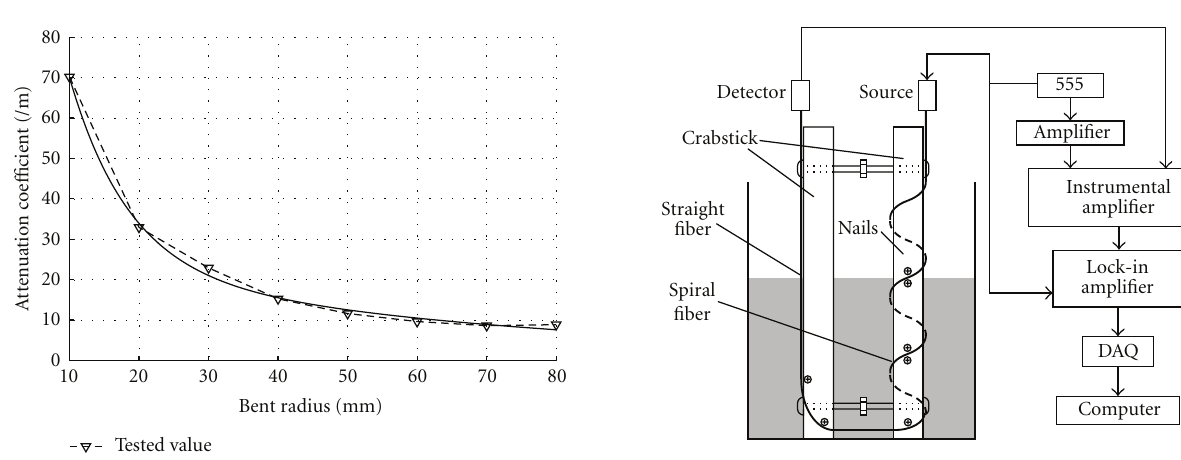
Figure 9: Schematic of liquid level